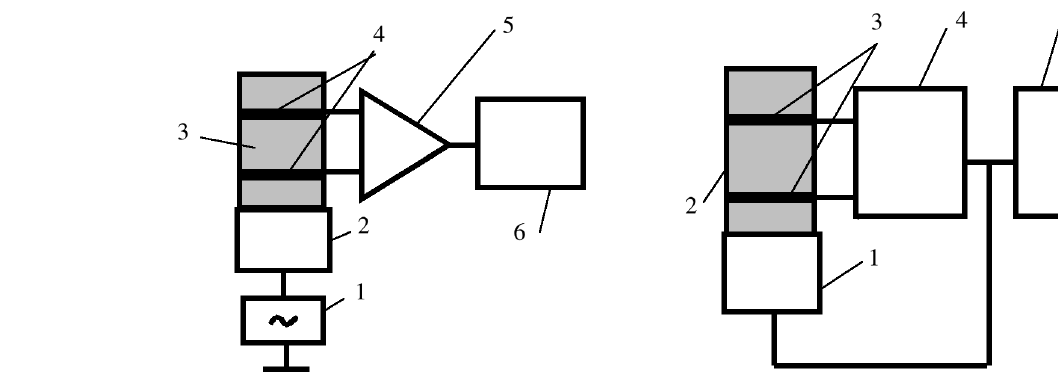
Fig. 2 . The skeleton diagram of the laboratory device for the investigation of self-oscillations: 1 – piezoelec-